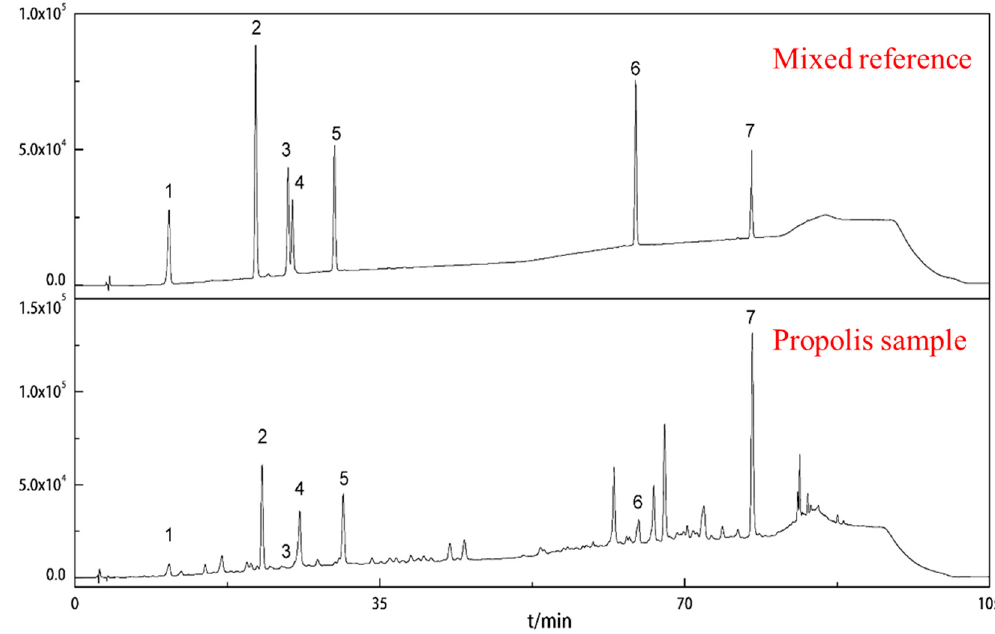
Figure 3. Comparison of chromatograms obtained at 310 nm of chlorogenic acid (1), caffeic acid (2), isochlorogenic acid B (3), isochlorogenic acid A (4), isochlorogenic acid C (5), caffeic acid phenethyl ester (6), and artepillin C (7) mix of standards and Brazilian green propolis sample.